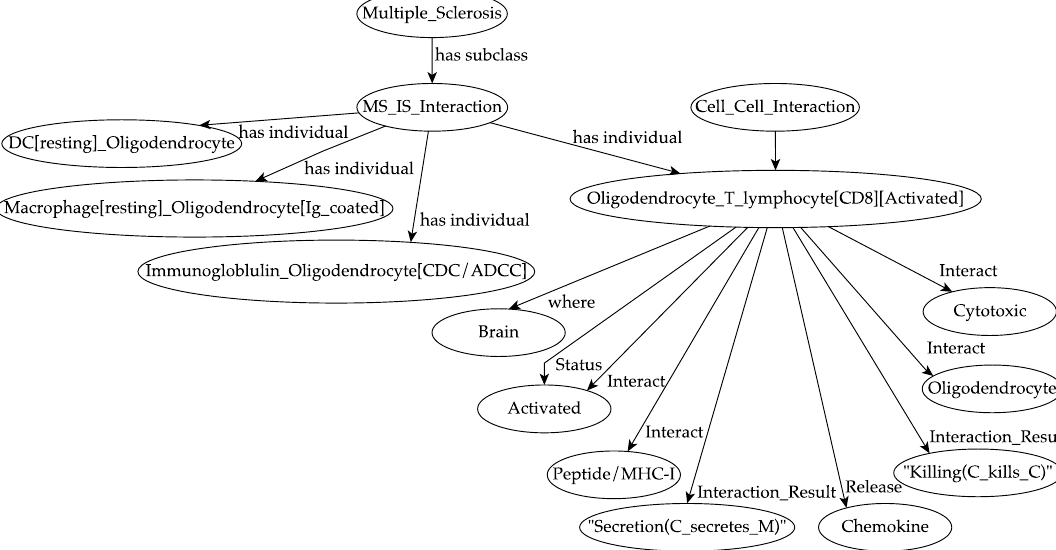
Figure 1. An overview of the ontology of a specific autoimmune interaction during multiple sclerosis (MS) dynamics. A previously activated cytotoxic T lymphocyte encounters its target, i.e., an oligodendrocyte, in the white matter portion of the brain. It recognizes, at the molecular level, the peptide / major histocompatibility complex (MHC-I) that is exposed on the surface of the oligodendrocyte. For each entity, the localization (i.e., the biological compartment in which the entities are present, in this specific case the brain) and the status (i.e., the di ff erentiation states that an entity can own, in this specific case “activated”, that means primed) are defined. The result of the interaction is the killing of the oligodendrocyte by the cytotoxic T lymphocyte and the local release of chemokine factors. Specifically, “C kills C” means that a cell, for example, a CD8 T lymphocyte, kills a peptide / MHC-1 presenting oligodendrocyte. “C secretes M” means that a cell, in this case, an oligodendrocyte, secretes specific molecules (i.e., chemokines) that attract further activated e ff ector immune cells.